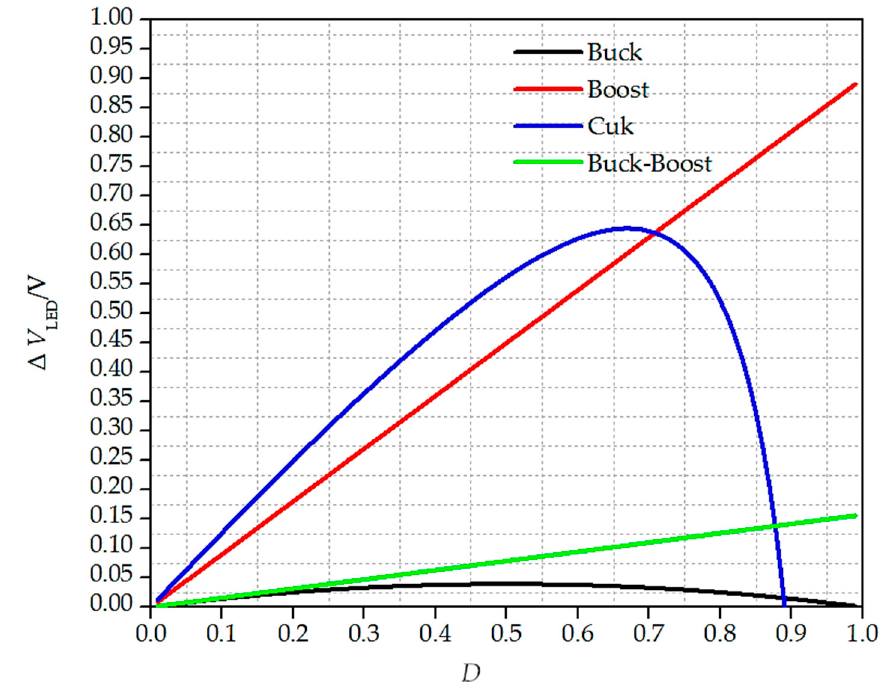
Figure 15. Relationship between voltage ripple magnitude and D of the LED in transistor converters.